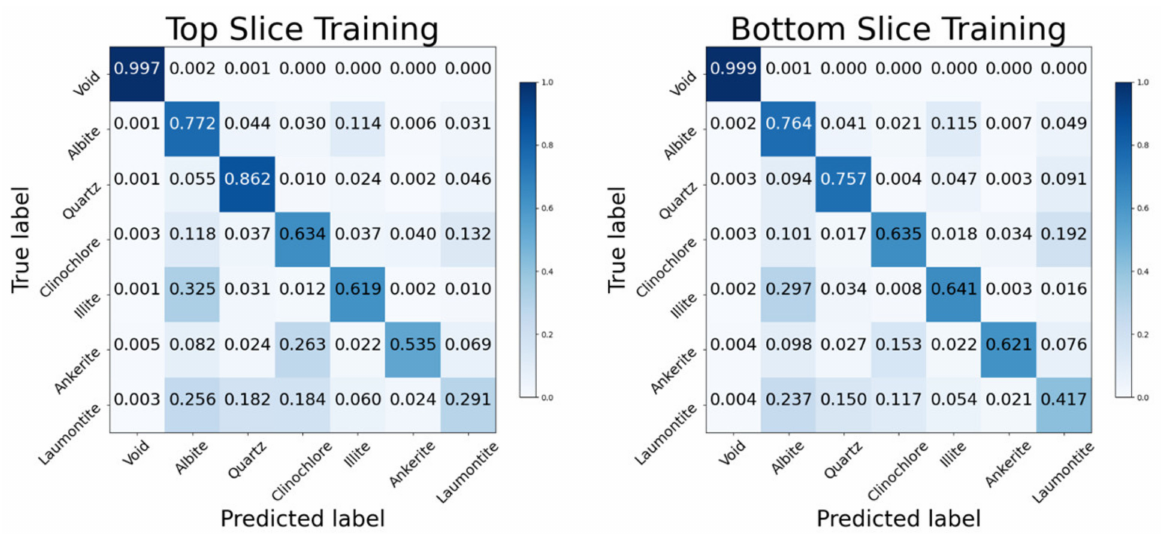
Figure 7. Pixel-wise confusion matrices for the segmentation of the top and bottom surfaces, showing the ratio of correctly and incorrectly predicted labels of the segmentation model in comparison to the true labels from the µ XRF